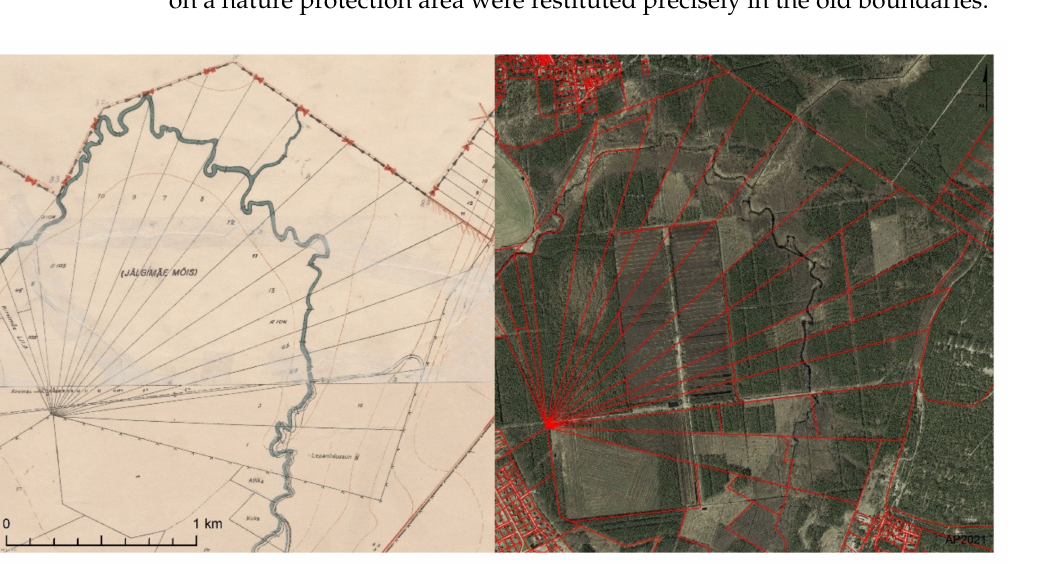
Figure 4. Map of property borders in Pääsküla bog near capital Tallinn. Männiku village, Saku municipality, Harju county (source: Cadastral map of 1930–1944, Cadastral map of 1 January 2021 based on orthophoto from 30 April 2021; Estonian Land Board